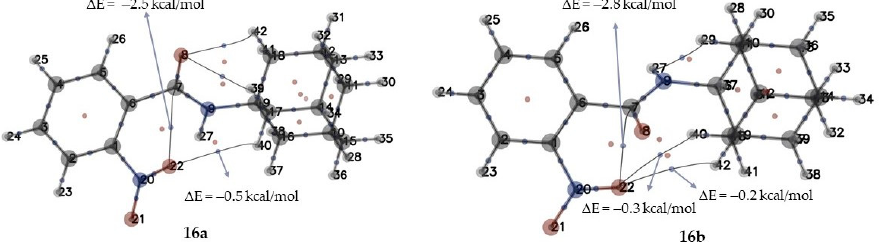
Figure 6. AIM analysis and estimation of hydrogen bonds strength results: two types of critical points are shown: bond critical points (3; − 1) correspond to blue points between nuclei; critical points in the ring (3; +1) correspond to red points; Δ E—value of hydrogen bonds strength.